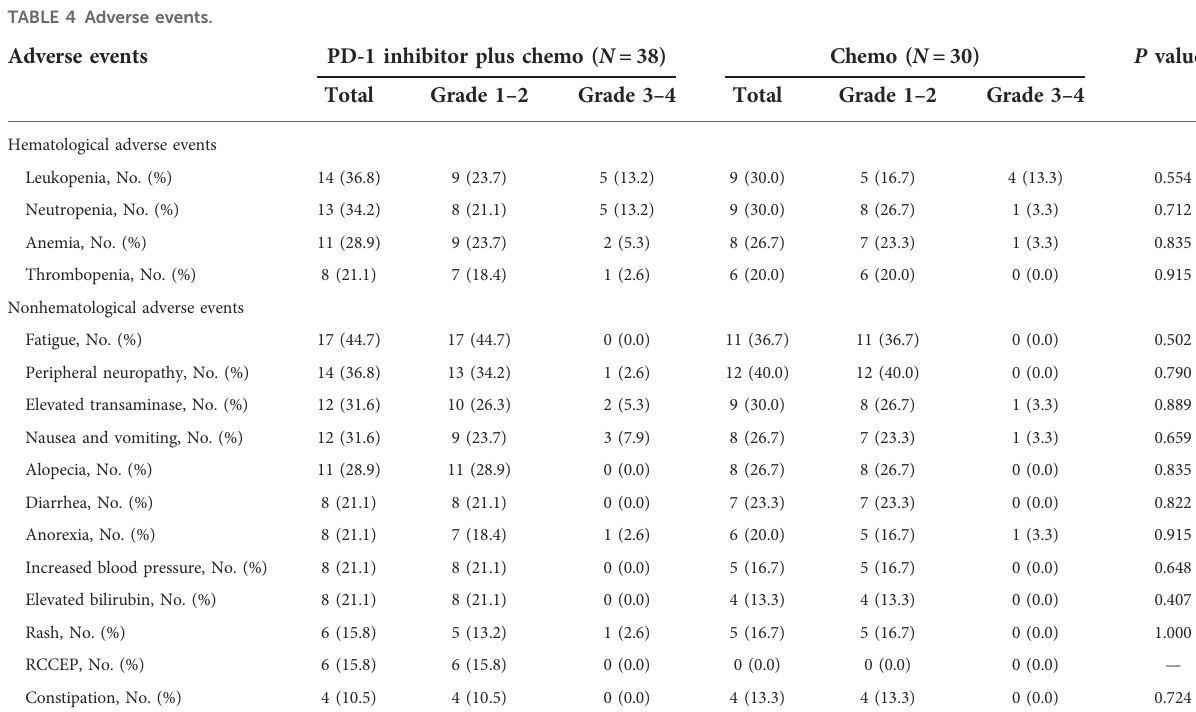
TABLE 4 Adverse